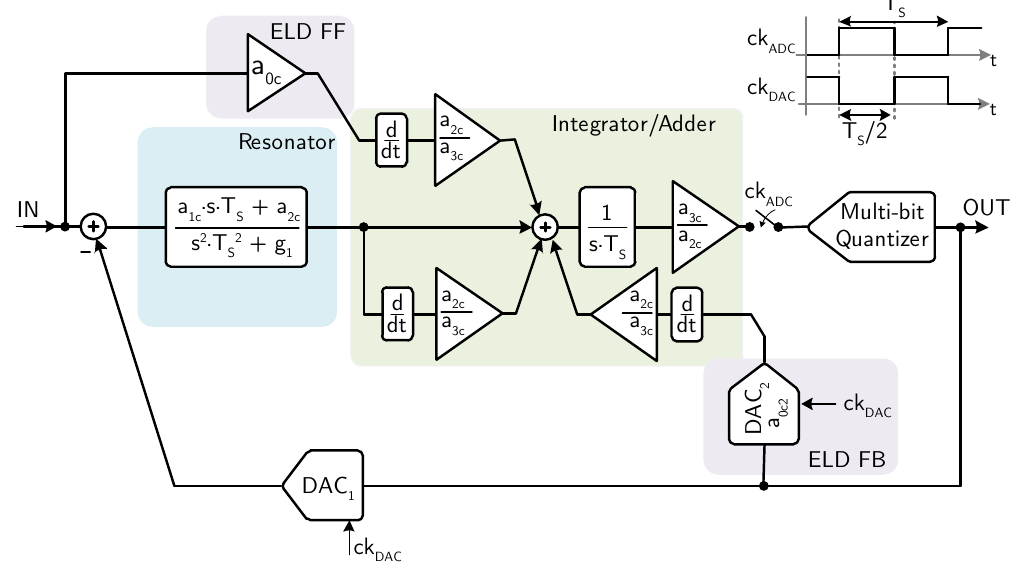
Figure 18. Block diagram of the third-order CT ΣΔ modulator (example